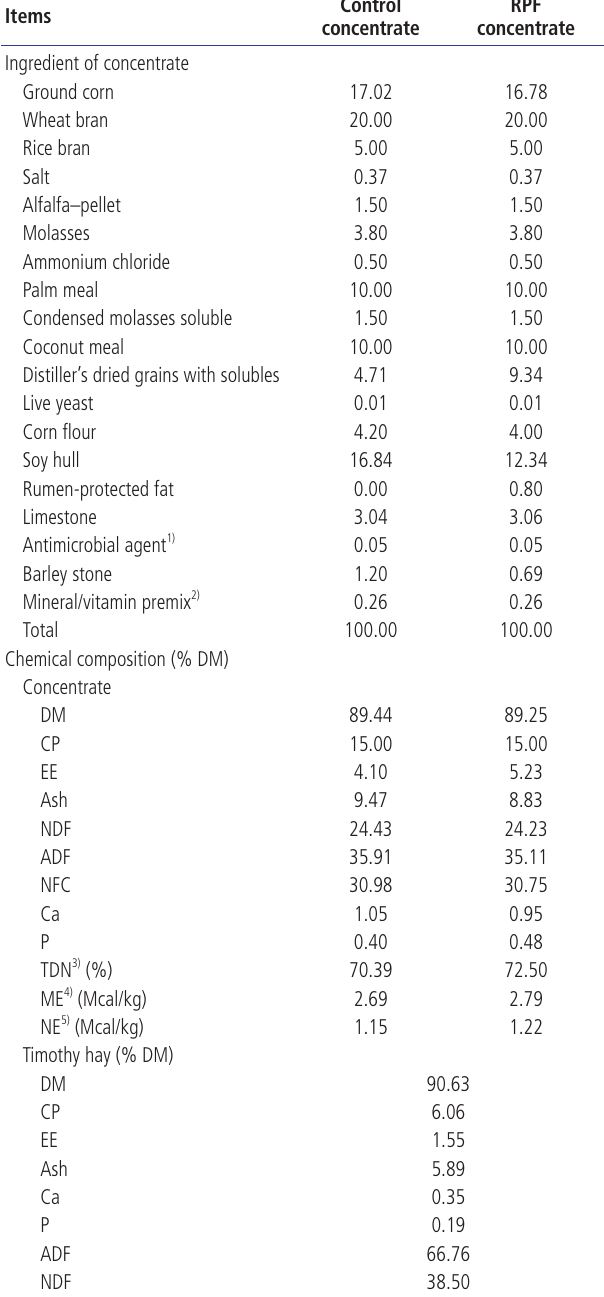
Table 1. Ingredient of concentrate and composition of experimental diets for Korean cattle steers during July through October of